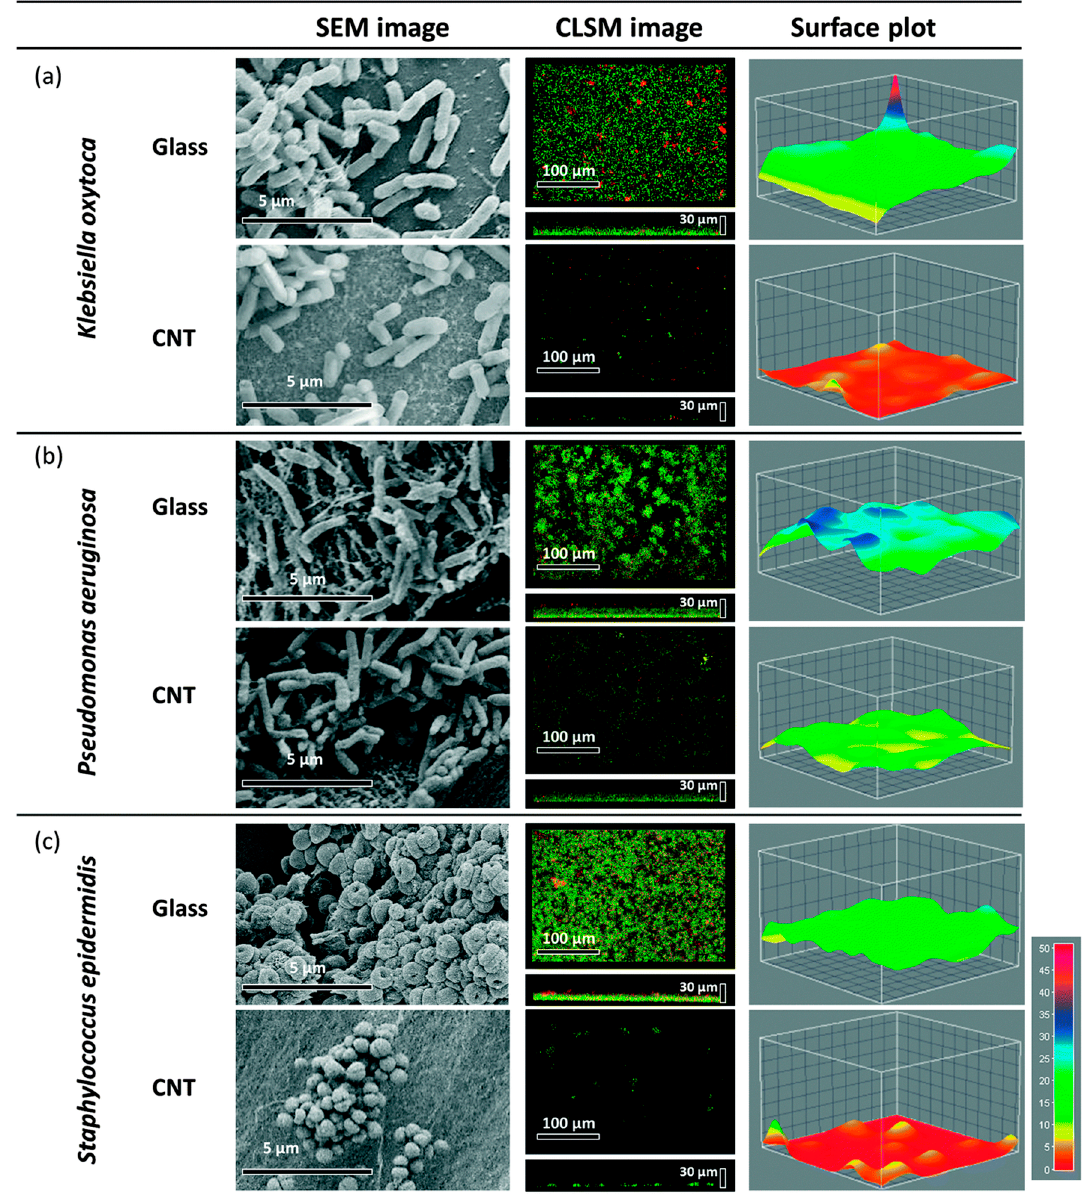
Figure 3. Scanning Electron Microscope (SEM), Confocal Scanning Laser Microscopy (CLSM) and surface plots of biofilm formation of K. oxytoca ( a ); P. aeruginosa ( b ) and S. epidermidis ( c ) on multi-wall carbon nanotubes (MWCNT) (tube length 540 µ m) and glass control. Reprinted with permission from Reference [100].